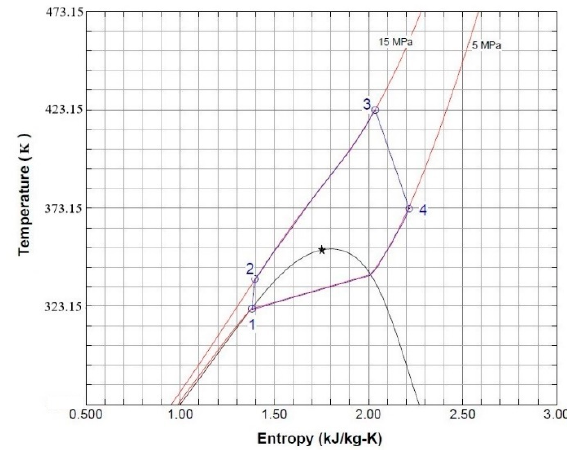
Figure 2. Temperature–entropy (T–s) diagram (CO 2 / R161: 50 / 50 wt.%) of the transcritical Rankine cycle (TRC).